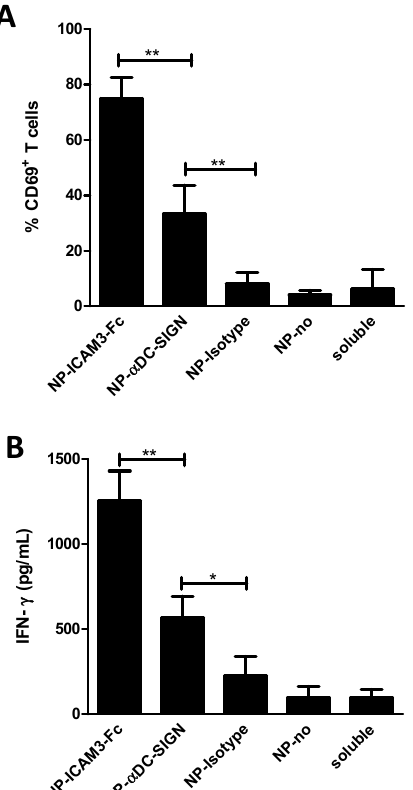
Figure 4. ICAM3-Fc coating of NP vaccines induces stronger CD8 + T cell activation and IFN- Ɣ production than antibody coating. Human monocyte-derived DCs were cultured in the presence of uncoated (no) and ligand-coated NP vaccine harbouring gp100 272-300 peptide Ag and TLRLs. Untreated DCs and DCs cultured with soluble gp100 272-300 peptide and TLRLs (soluble) served as controls. Next, DCs were co-cultured with gp100 280-88 -specific naïve CD8 + T cells. ( A ) CD8 + T cell activation was determined by measuring expression of the early T cell activation marker CD69. Data represent mean values ±SD of 5 experiments performed in duplicate. ( B ) CD8 + T cell function was determined by measuring IFN- γ levels in the supernatant. Data are means ±SD of 3 experiments performed in duplicate. Significant difference were analysed applying one way or two way ANOVA with Bonferroni post-tests, n.s. no significant, * = p < 0.05, ** = p < 0.01.